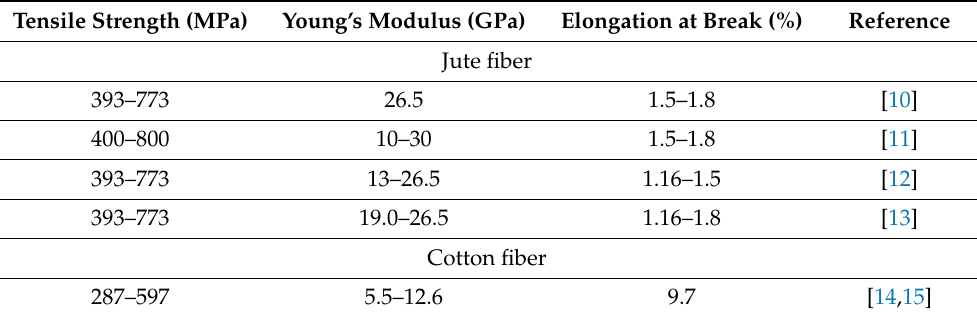
Table 1. Mechanical properties of jute and cotton